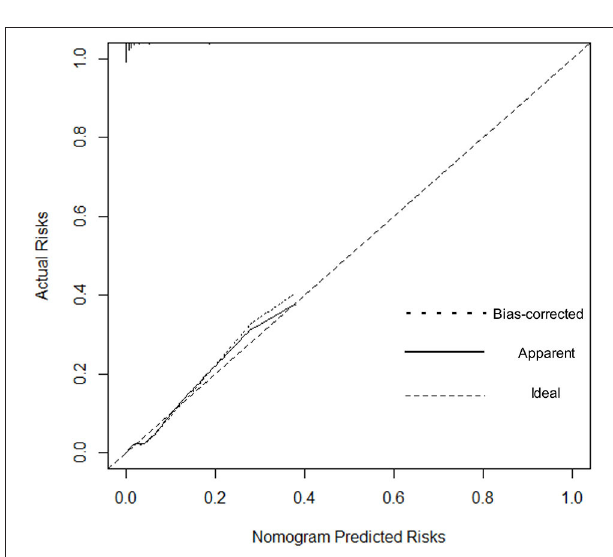
FIGURE 6 | Calibration curve. The dashed line represents ideal predictions. The plot illustrates the accuracy of the best-fit model (Apparent) and the bootstrap model (Bias-corrected) for predicting early-onset pre-eclampsia.